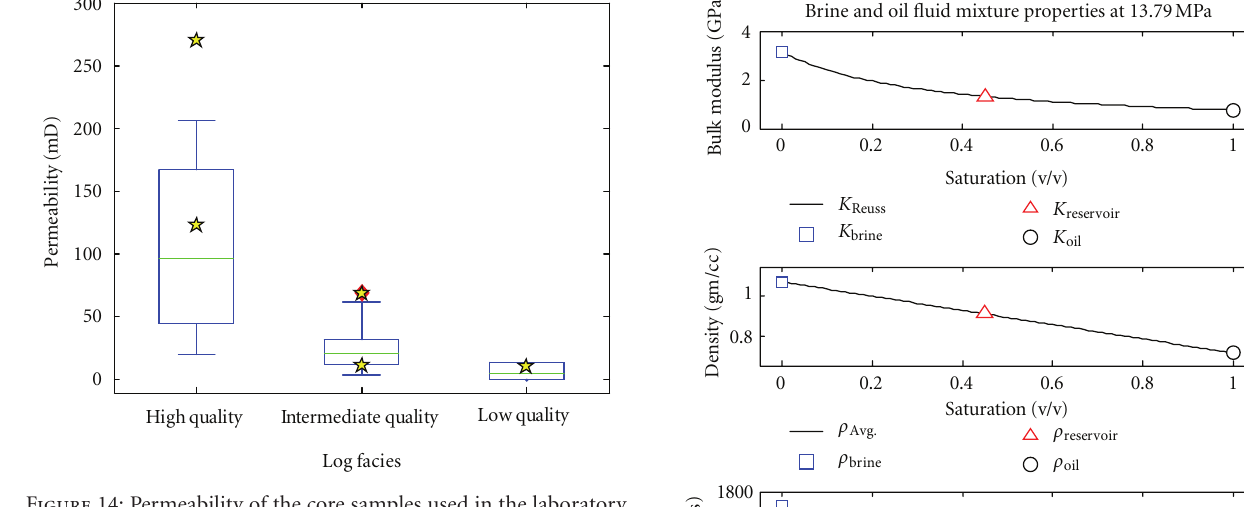
Figure 14: Permeability of the core samples used in the laboratory velocity measurements (stars) superimposed on the box and whisker plot of the permeability related to each log facies (from the well in Figure 13).